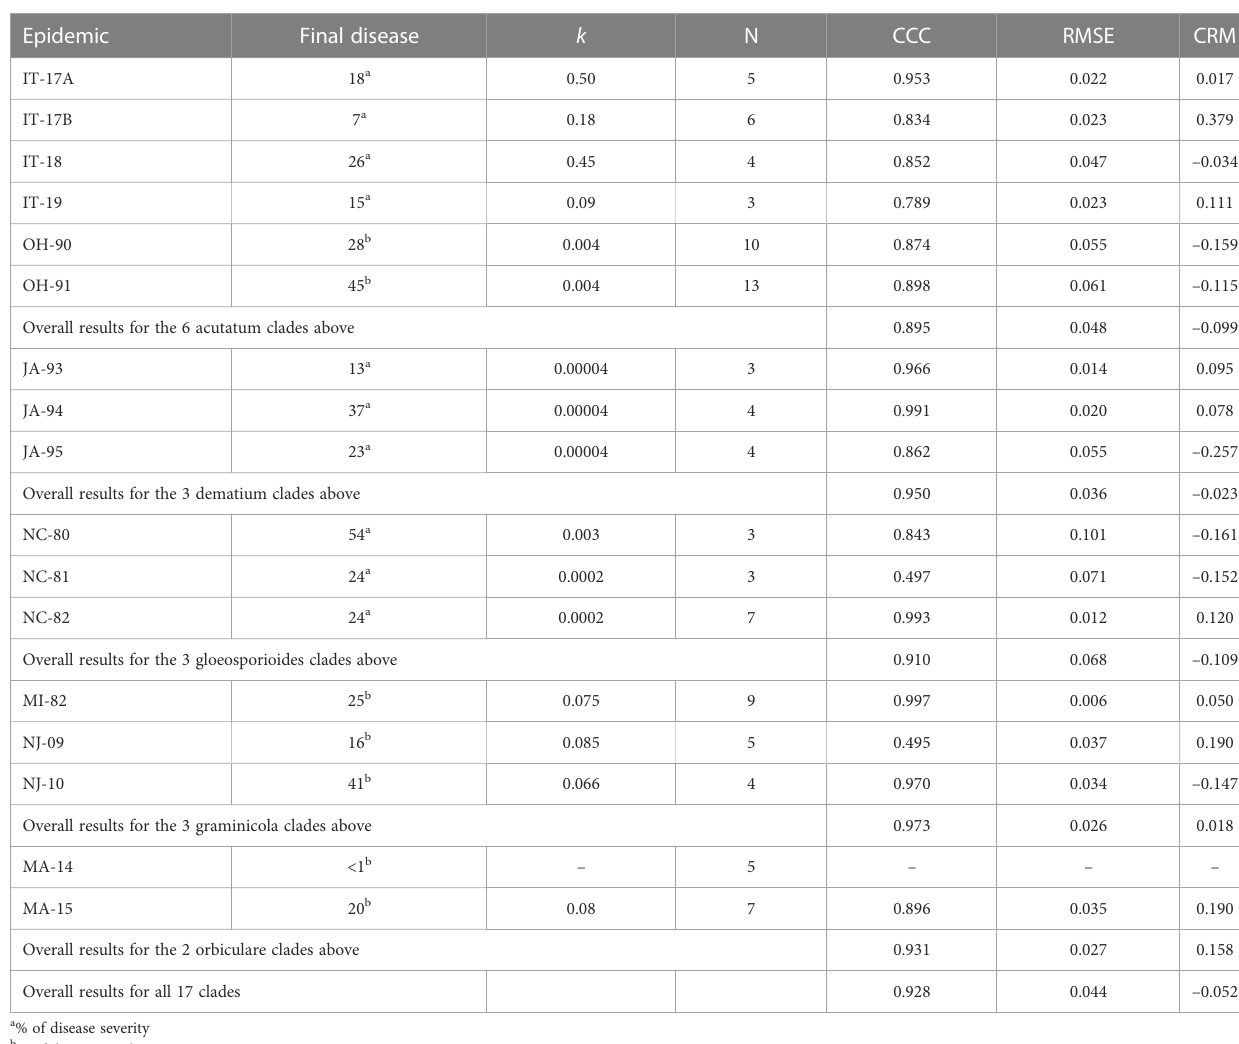
TABLE 5 Epidemics considered for model